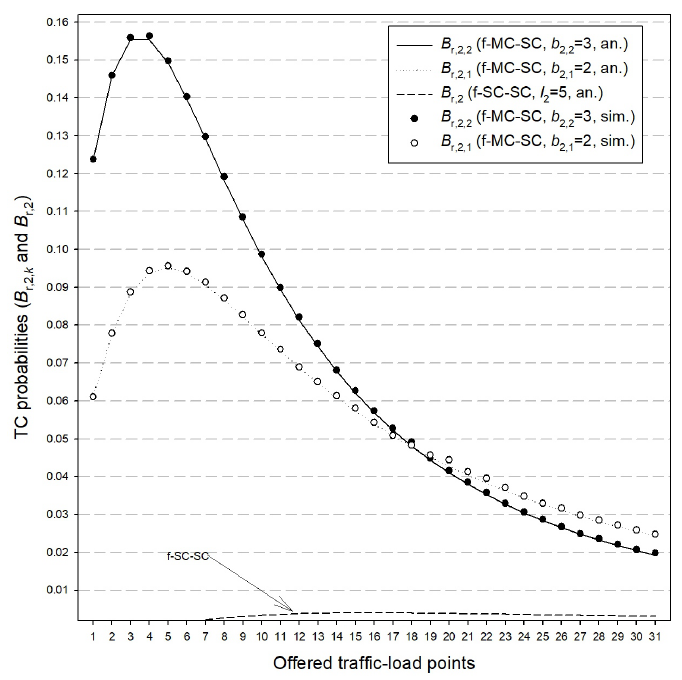
Figure 5. TC probabilities as the result of RRUs unavailability (2nd RRH).